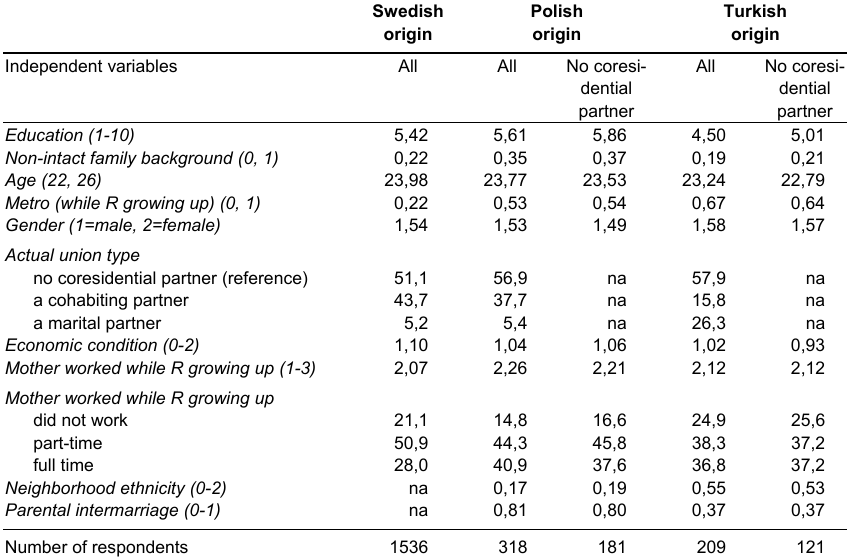
Swedish Polish origin origin